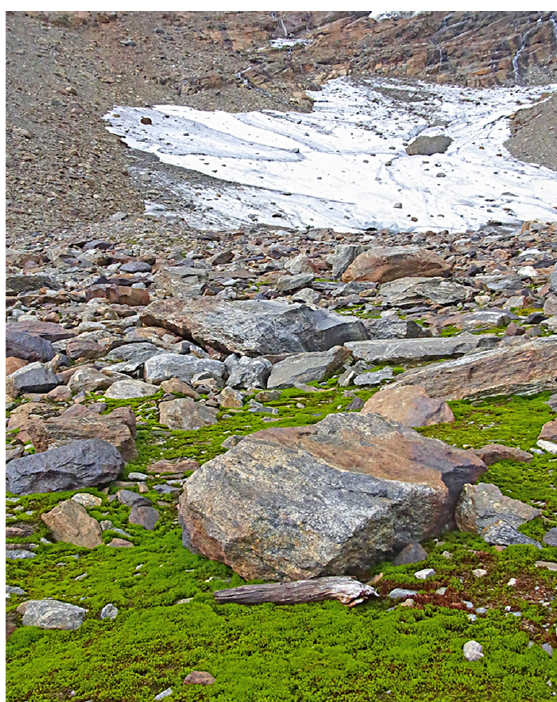
Figure 34: Tärnaglaciären (6). Unmistakable pine rem- nant, reasonably displaced by snow and water from a location higher upslope. 9020 cal. yr BP